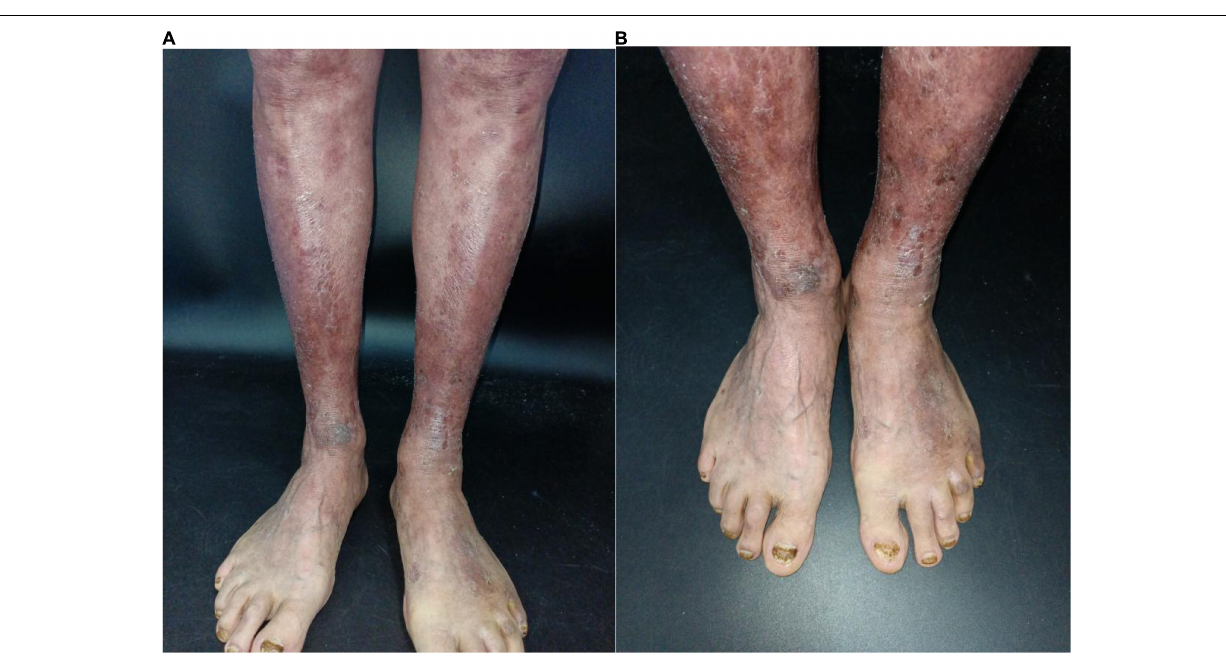
FIGURE 3 | (A,B) Clinical pictures of the patient. After 4-month treatment with anlotinib, nodules begin to subside, leaving dark brown violaceous